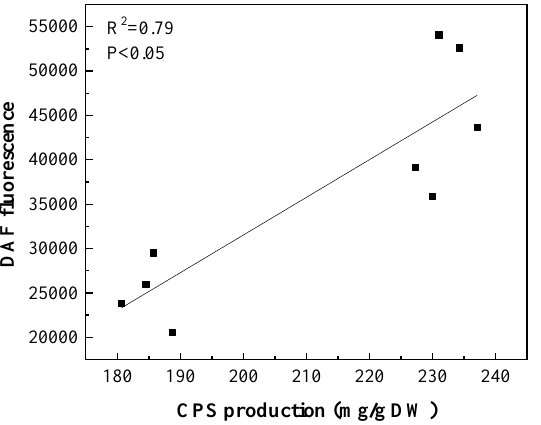
Figure 7. Relationship between changes in CPS production and NO under different culture condi- tions.